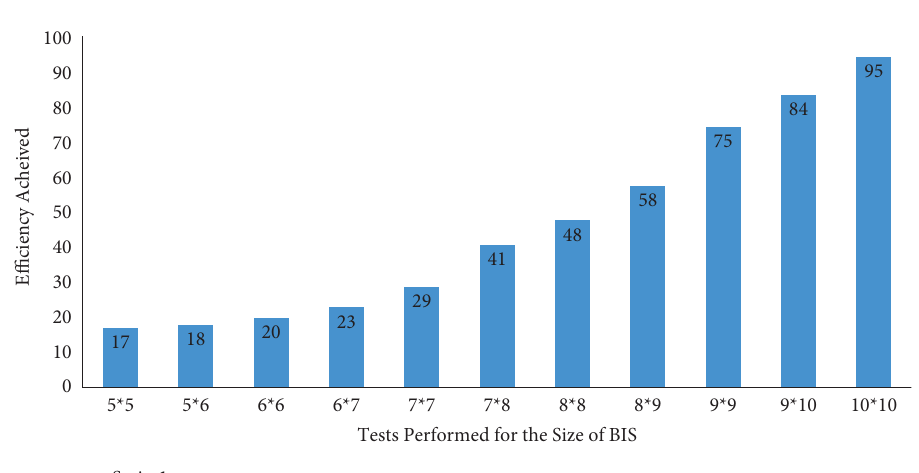
Tests Performed for the Size of BIS